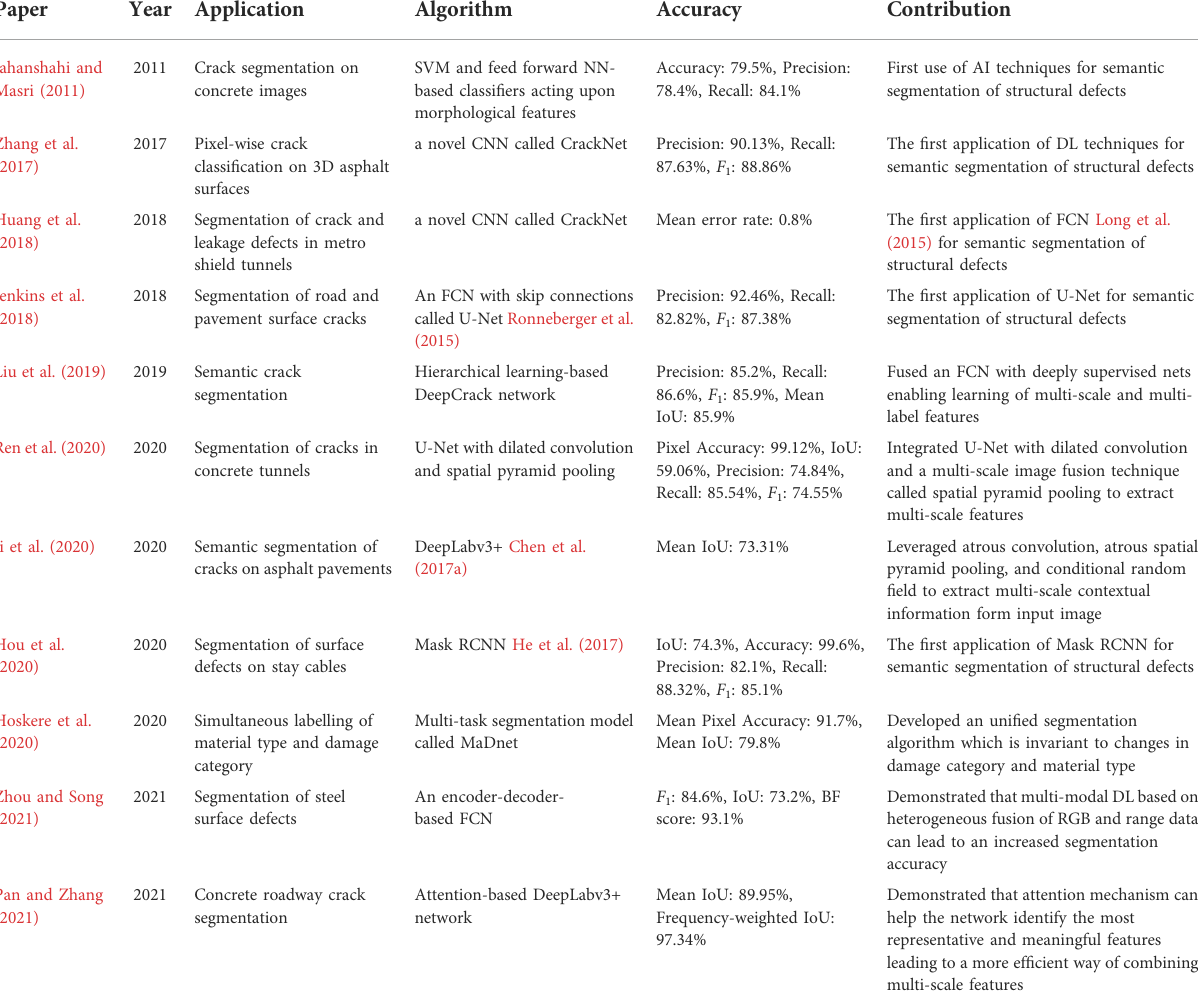
TABLE 3 Milestone papers focused on AI techniques for vision-based defect segmentation. BF score is a short from of boundary F 1